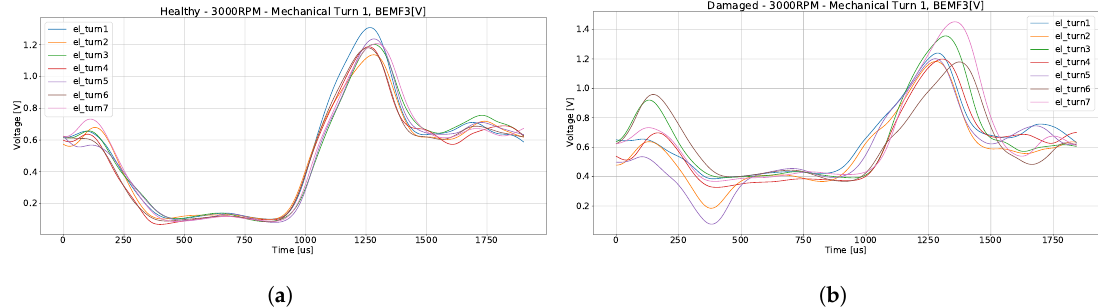
Figure 13. Superposition of the 7 electrical turns relative to the same mechanical turn, of a healthy and damaged motor running at 3000 RPM. ( a ) Healthy motor; ( b ) Damaged motor.